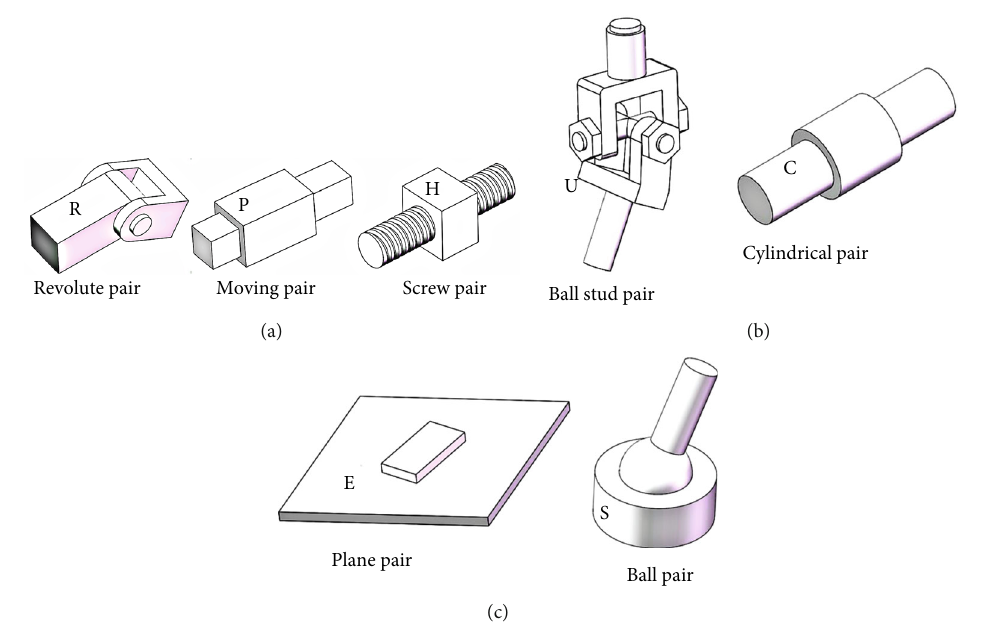
Figure 4: Basic modular units.